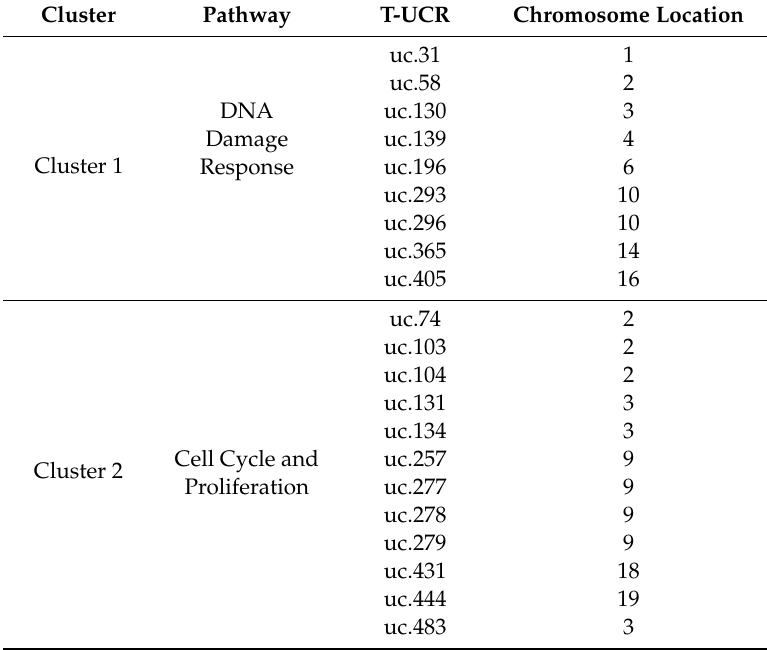
Table 3. A list of T-UCR clusters and the associated pathways in neuroblastoma patients. Cluster